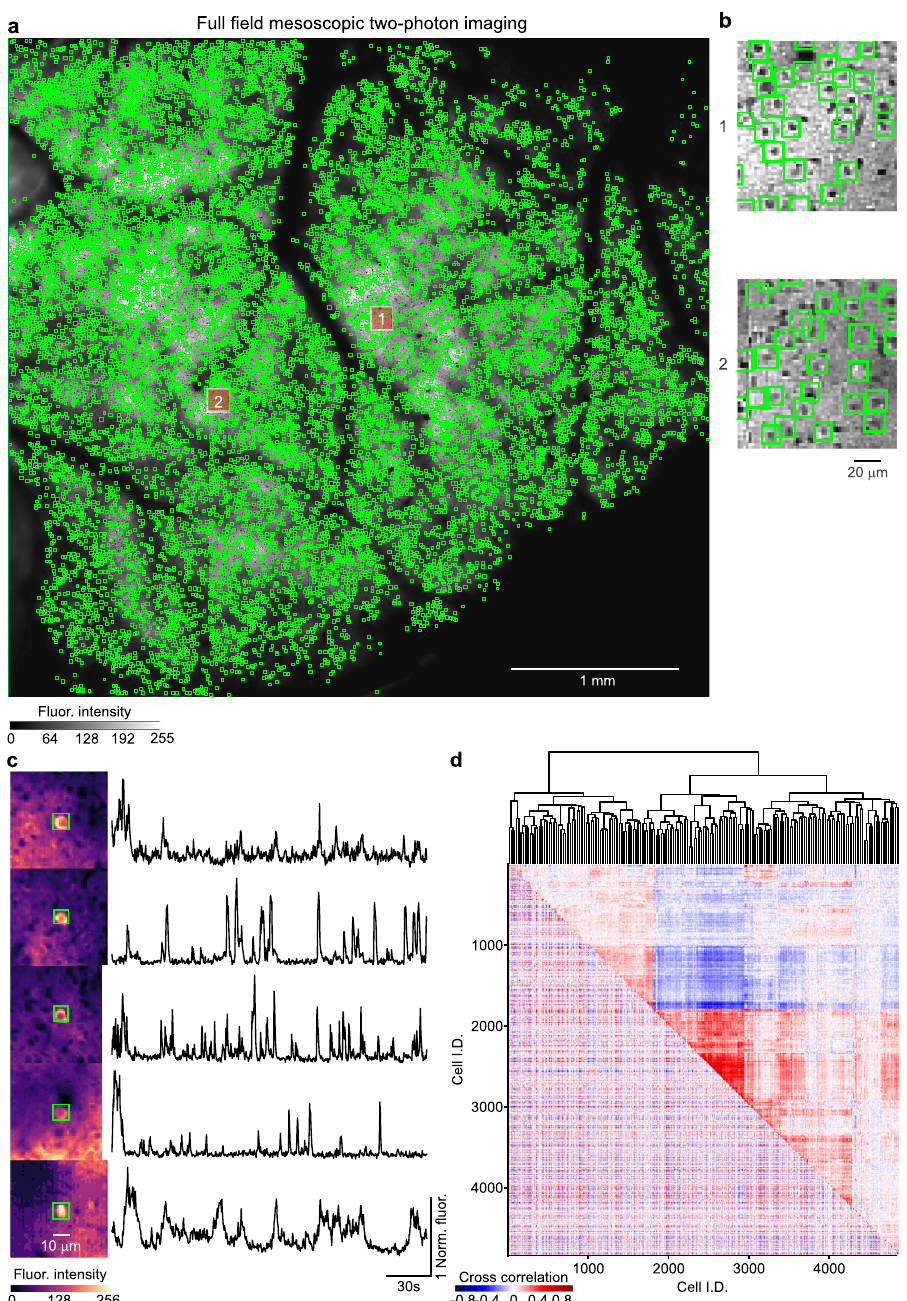
Fig. 9 CITE-On analysis of mesoscopic two-photon imaging t-series. a , b Median projection of a mesoscopic imaging t-series showing GCaMP6s expressing neurons (mesoscopic data from ref. 7 ). Green boxes indicate cells detected by CITE-On (total: 4842 cells). Two regions are highlighted by the red and white squares, and are shown at an expanded spatial scale in b . Greyscale in a applies also to b . c Left: fi ve representative cells detected by CITE- On. The brightest cell in each FOV was selected. Right: corresponding CITE-On extracted fl uorescence traces in the fi rst 230 s of the t-series. d Cross- correlation matrix (bottom-left triangle) calculated on the background-subtracted traces extracted by CITE-On on all detected cells in the fi rst 7000 frames and relative dendrogram (top-right